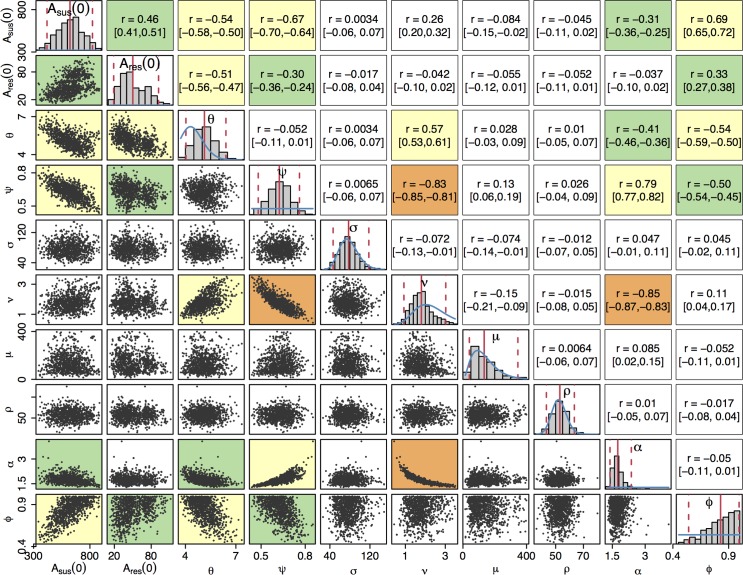
Posterior distributions of parameters.The diagonal plots show histograms of the posterior distributions for all sampled parameters. The blue lines show prior distributions, and the red lines indicate posterior mean and 95% credible intervals. The plots below the diagonal show scatter plots based on 1,000 samples from the posterior, illustrating the relationships between pairs of estimated parameters. An orange background indicates a correlation higher than 0.8, a yellow background indicates a correlation between 0.5 and 0.8, a green background indicates a correlation between 0.3 and 0.5, and a white background indicates a correlation less than 0.3. The plots above the diagonal show the corresponding correlation coefficients with the 95% credible intervals in parentheses.